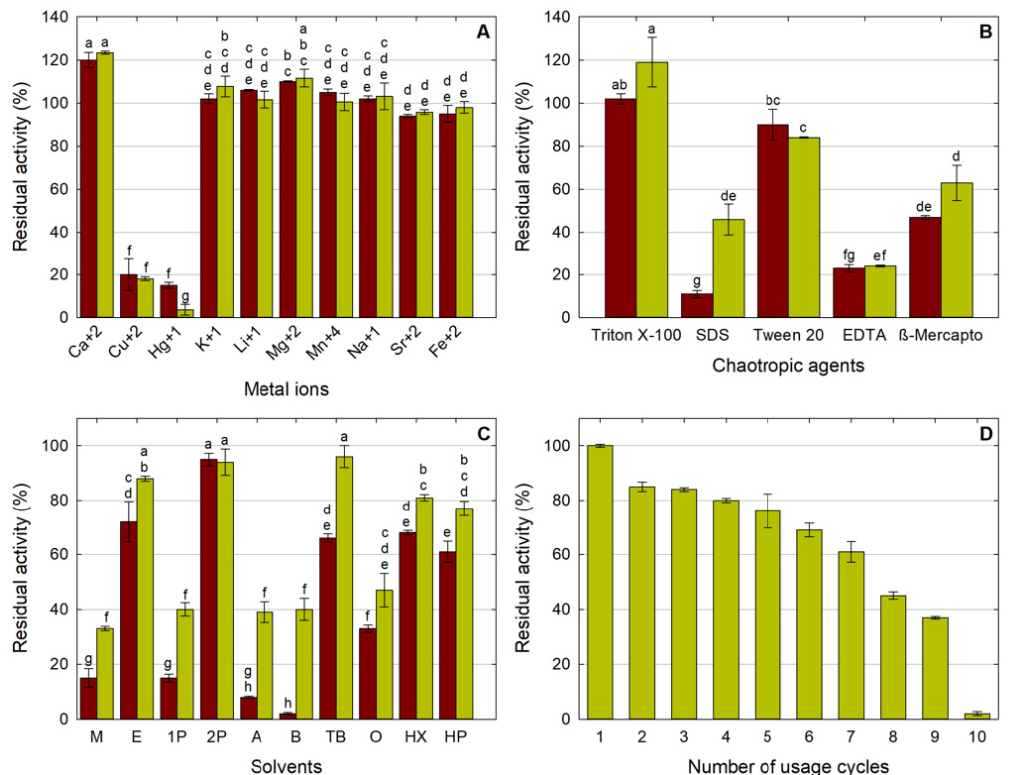
Figure 5. Characterization of LipMatCCR11-CLEAs. ( A ) Stability against metal ions; ( B ) stability on chaotropic agents; ( C ) stability on solvents M: methanol, E: ethanol, 1P: 1-propanol, 2P: 2-propanol, A: acetone, B: butanol, TB: tert -butanol, O: octanol, HX: hexane, HP: heptane. ( D ) Reusability of LipMAtCCR11-CLEAs. All values are the mean of three replicates Red: LipMatCCR1, Green: LipMatCCR11-CLEAs. Error bars represent the standard deviation within the data set. Different lowercase letters indicate significant differences according to Tukey’s multiple comparison tests ( p < 0.05). The 100% value corresponds to a CLEA activity of 7755 ± 144 U/g.